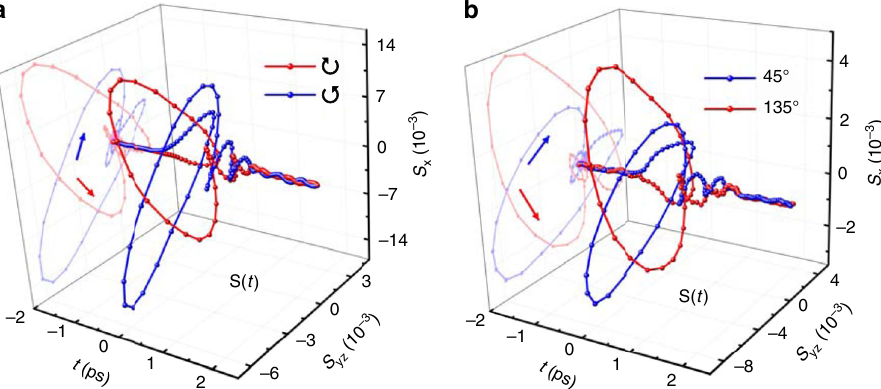
ð t Þ ^ s þ S ð t Þ ^ p (cid:2) from TaAs(112). a and b are for circularly and linearly polarized pump light, respectively. The Fig. 2 The far- fi eld EO signals S( t ) ½¼ S x yz colored arrows indicate different optical chiralities of the emitted THz wave: left-handed (blue) and right-handed depending on the pump polarization and the sample faces and, hence, has a de fi ned chirality. According to the polarization trajectory ( S yz ( t ), S x ( t )) in Fig. 2a and b, chirality of the helical THz pulse can be instantaneously switched by varying the circular or linear polarization of the pump light.